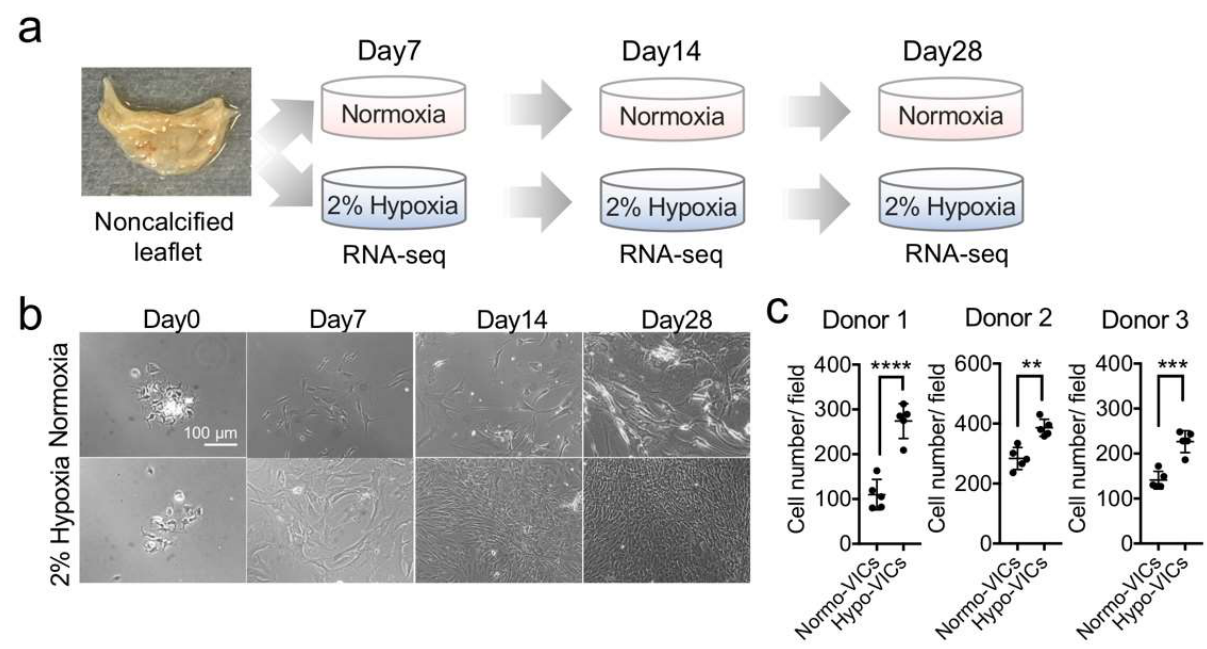
Figure 1. VICs exhibit increased growth under hypoxia. ( a ) Schematic of experimental strategy for RNA-sequencing. ( b ) Phase-contrast micrographs of VICs cultured under normoxia and 2% hypoxia at 0, 7, 14, and 28 d. Bar = 100 µ m. ( c ) Quantifications of proliferation in hypo- and normo-VICs. ** p < 0.01, *** p < 0.001, **** p < 0.0001.